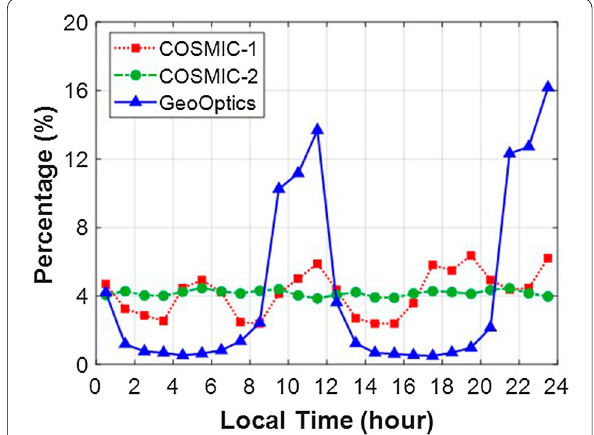
Fig. 5 Local time distributions for COSMIC-1 (dotted curve with red squares), COSMIC-2 (dash-dotted curve with green circles) and GeoOptics (solid curve with blue